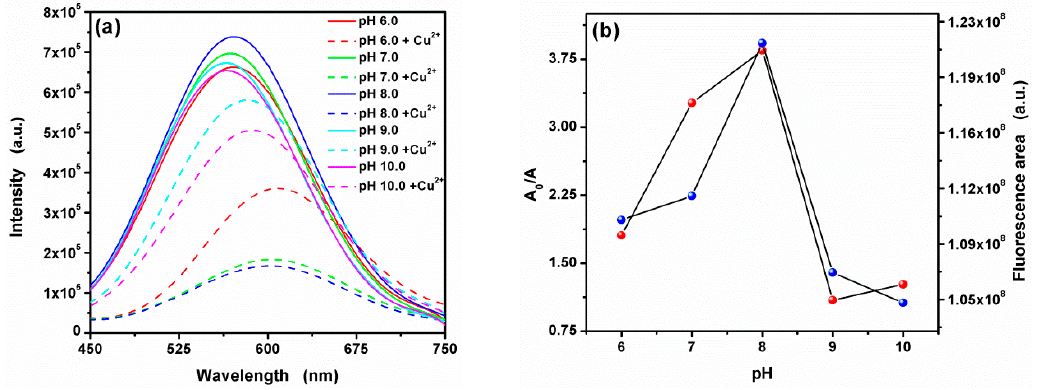
Figure 9. ( a ) Effect of pH on the fluorescence intensity and ( b ) Relative fluorescence area (A 0 /A) (red) and the pH dependence (blue)of CA-CdS QDs in the absence and presence of 50 μ M Cu 2+ .